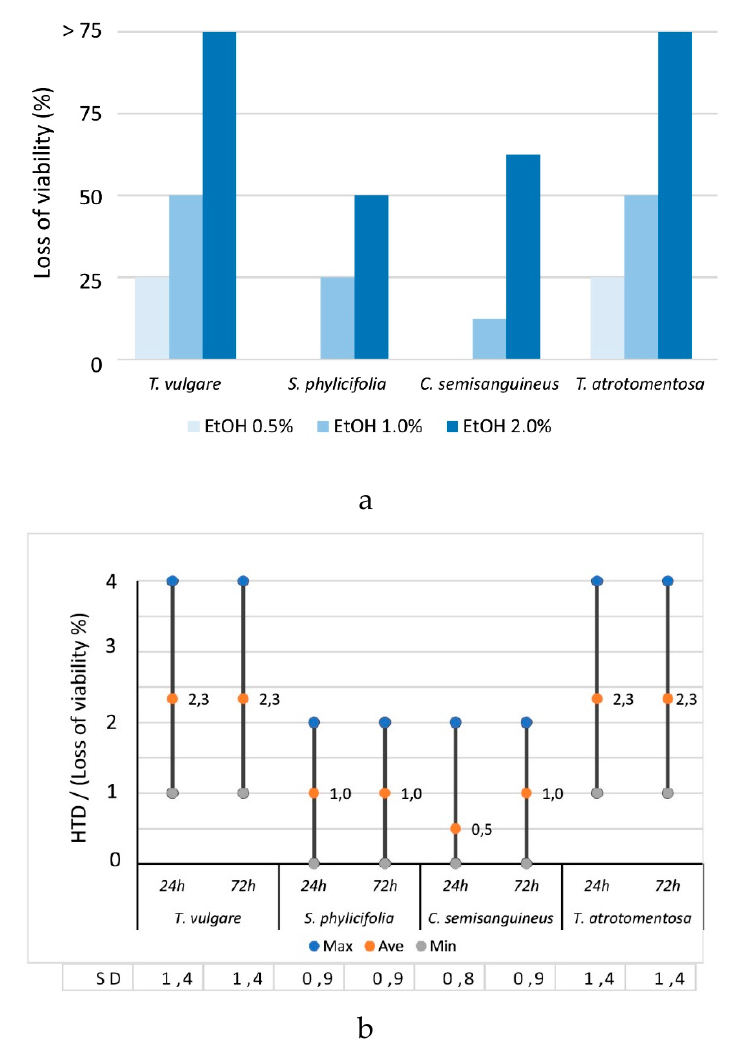
Figure 2. The Toxicity of the Plant and Fungal Materials. ( a ) The e ff ect of EtOH concentration on the average changes in the morphology and the loss of viability% for the di ff erent EtOH dilutions. Samples of 24 h and 72 h exposure times are included. (r s = 0.863, p < 0.0005, n = 192). ( b ) The e ff ect of time on the HTD values (changes in morphology and loss of viability (%) where 1 < 25%, 2 = –50%, 3 = –75%, 4 > 75%). The ranges and average values are marked in the columns and standard deviations (SD) at the bottom. The results (n = 195) include EtOH concentrations of 0.5, 1 and 2%.